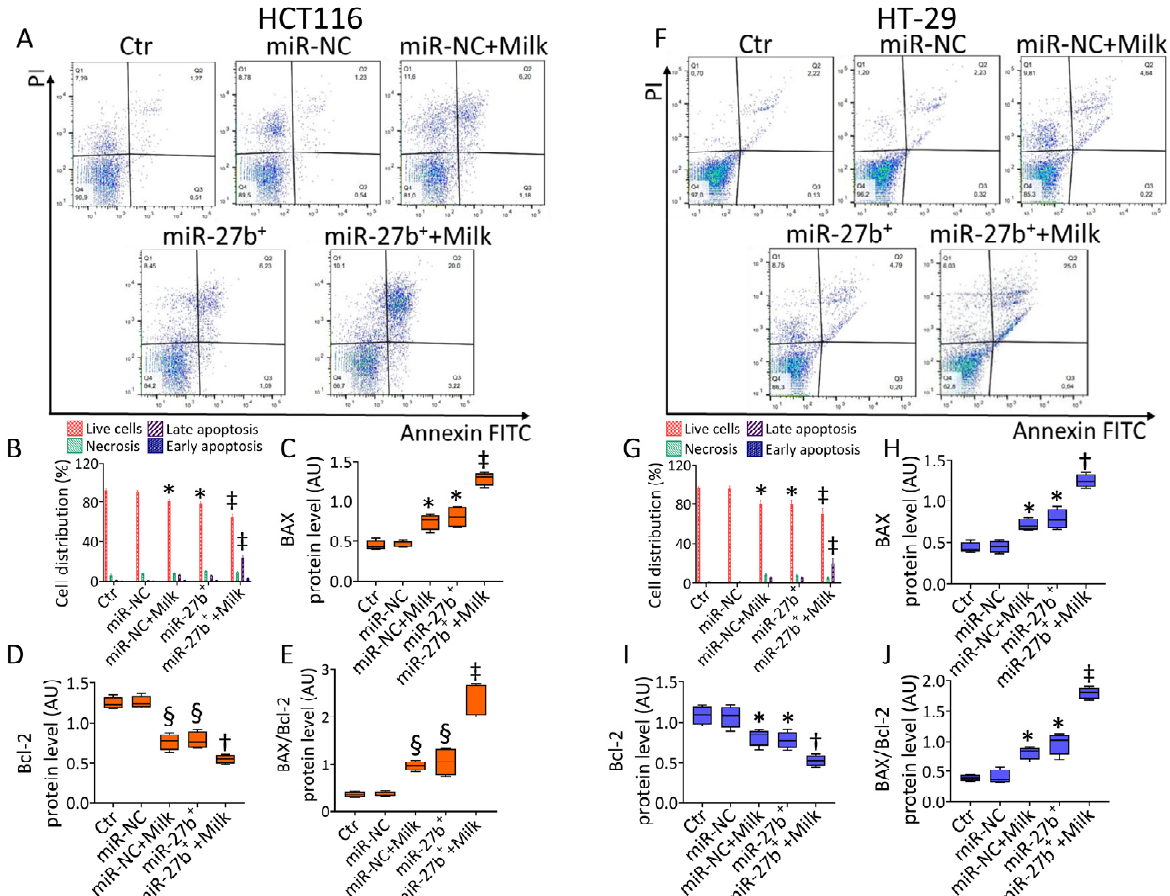
Figure 3. MiR-27b + +Milk induced CRC apoptosis. ( A ) Representative dot plots and analyses of annexin V-FITC and propidium iodide (PI)-staining and immunoblotting analyses of Bax/Bcl-2 protein levels in ( A – E ) HCT116 and ( F – J ) HT-29 cells transfected with 30 nM mimic Negative Control (miR-NC) and miR-27b mimic (miR-27b + ) or with miR-NC and miR-27b + before 72 h with 40% v / v milk treatment (miR-NC+Milk and miR-27b + +Milk). Control cells (Ctr) were treated with the highest volume of HBSS-10 mM Hepes. Cell mortality and viability were assessed using flow cytometry detecting at least 20,000 events. Lower left quadrant: viable cells; upper left quadrant: necrotic cells; lower right quadrant: early apoptotic cells; upper right quadrant: late apoptotic cells. Western blotting results ( n = 4) are expressed as arbitrary units (AU). * p < 0.05 vs. miR-NC; § p < 0.01 vs. miR-NC; † p < 0.05 vs. miR-27b + ; ‡ p < 0.01 vs. miR-27b + .